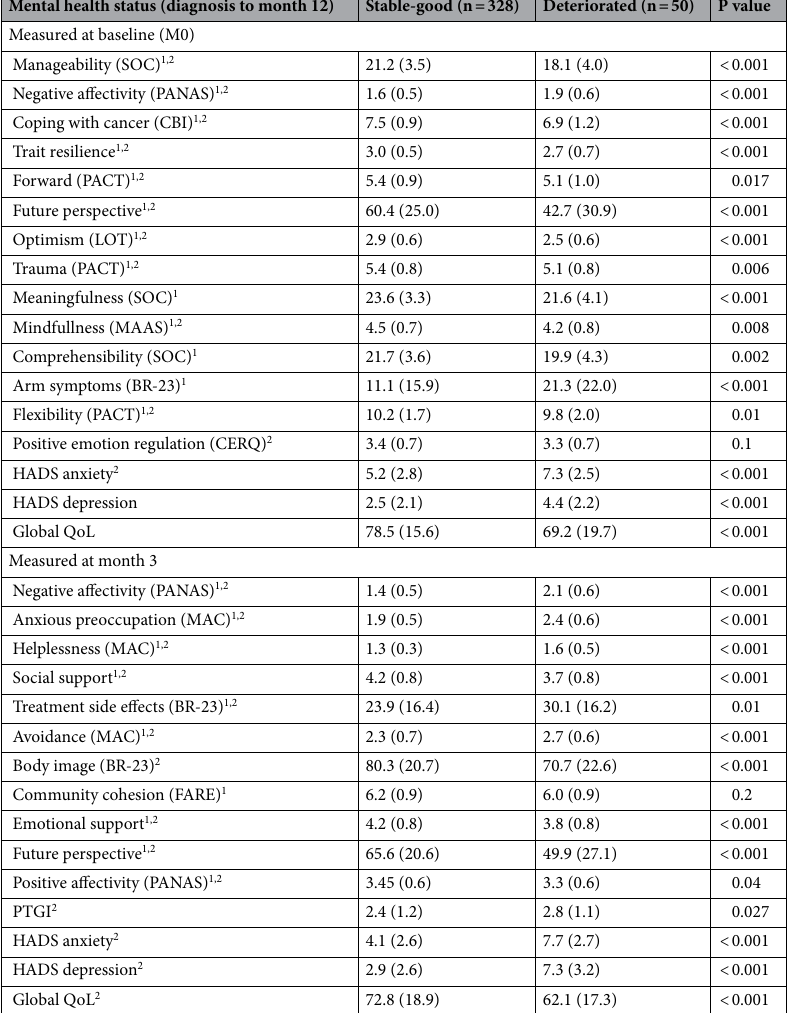
Table 3. Psychosocial characteristics that optimally differentiated patients who displayed stable-good from those who showed deteriorating mental health according to machine learning models 2 and/or 1. Values are means (SD). Superscripts indicate important features within Model 1 and 2, respectively. SOC Sense of coherence, LOT Life orientation test, MAAS Mindful attention awareness scale, PANAS Positive and negative affect, CERQ Cognitive emotion regulation questionnaire, CBI Cancer behavior inventory, PACT Perceived ability to cope with trauma, BR-23 Breast cancer-23, MAC Mental adjustment to cancer, PTGI Post-traumatic growth inventory, FARE Family resilience, HADS Hospital Anxiety and Depression Scale.